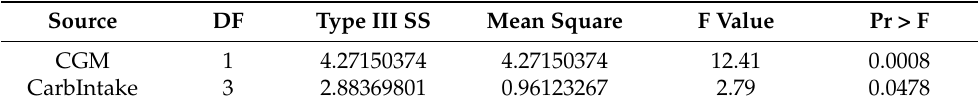
Table A11. A1C ≥ 7% with CGM and CarbIntake as independent variables.